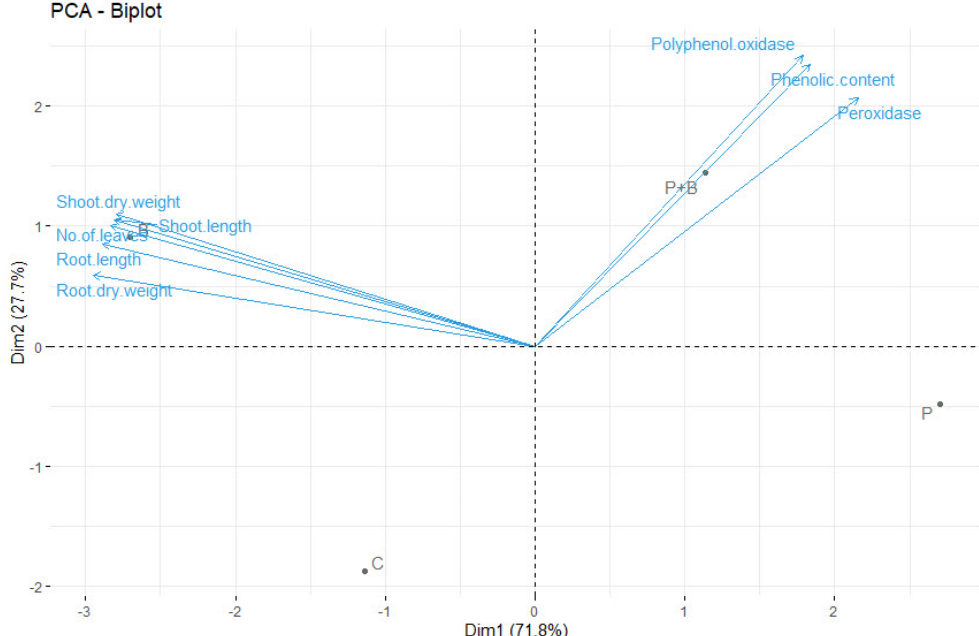
Figure 5. Ordination biplot of principal component analysis of the studied variables. C: non-treated with B. subtilis SR22 and uninfected; P: non-treated with B. subtilis SR22 and infected; B: treated with B. subtilis SR22 and uninfected; and P+B: treated with B. subtilis SR22 and infected .